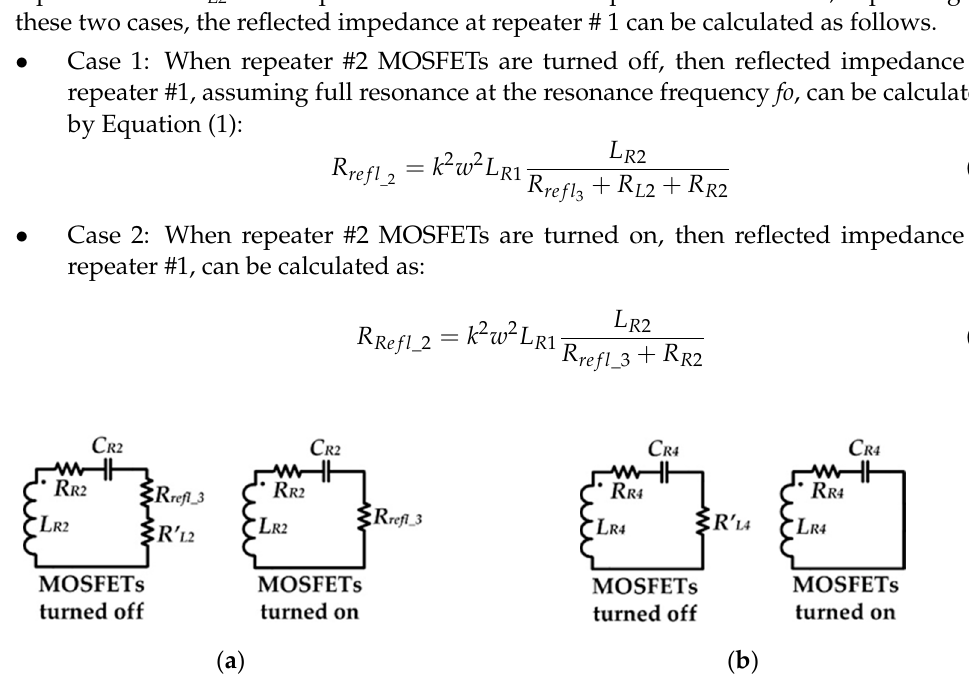
Figure 7. ( a ) Equivalent circuit of repeater #2 ( a ) when its MOSFETs are turned off or on ( b ) Equiv- circuit of the last receiver when its MOSFETs are turned off or on ( b